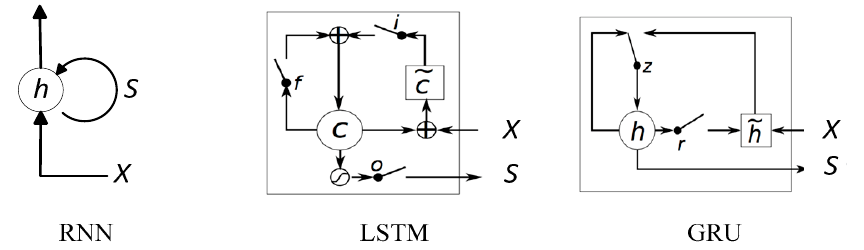
Figure 1. The structure of the recurrent neural network (RNN) [9], long short-term memory (LSTM) [16] and gated recurrent unit (GRU) [17].